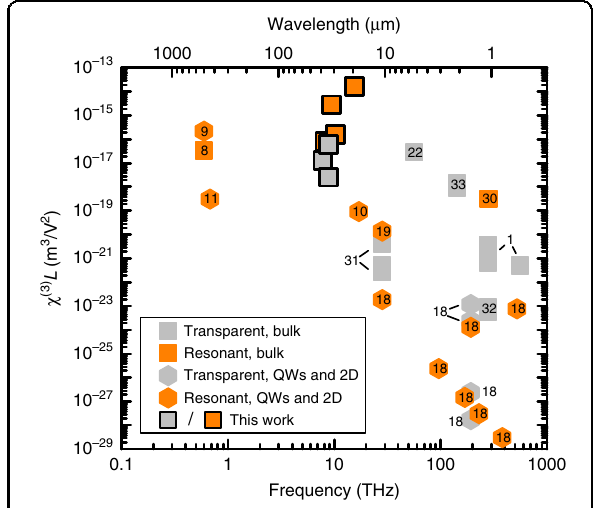
Fig. 3 Survey of coherent values of χ (3) L from this work (symbols with solid borders) and elsewhere. Experiments where the pump transition is virtual are labelled as “ Transparent ” , while experiments with real pump transitions and consequent absorption losses have been labelled as “ Resonant ” . Resonant quantum wells 9,19 ; graphene 10,11 and ref. 18 and references therein; free-carrier processes in Si 8 ; resonant bandgap-pumped bulk Si 30 ; transparent 2D materials (MoS 2 and black phosphorus) ref. 18 and references therein; transparent bulk semiconductors and insulators 22,31 – 33 and ref. 1